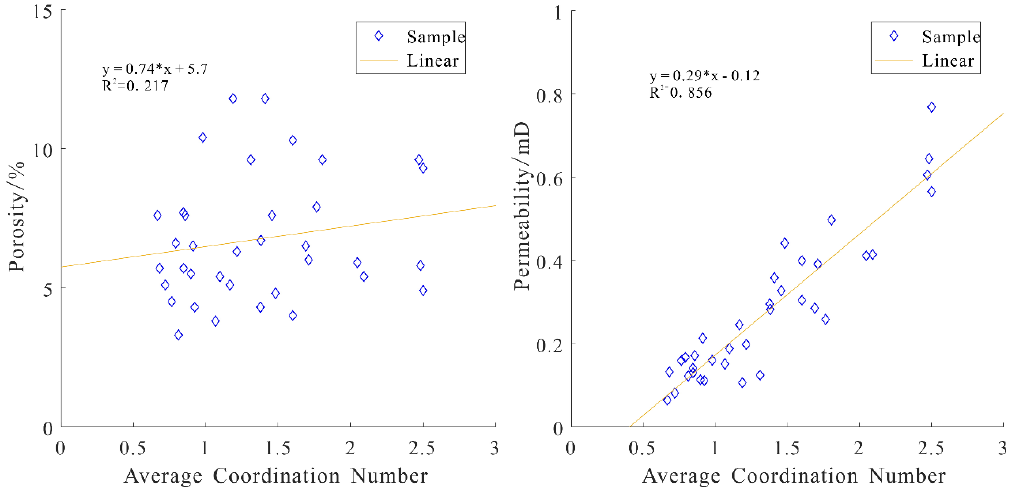
Figure 5. Relationship between average pore throat coordination number and porosity and the permeability of tight sandstone.